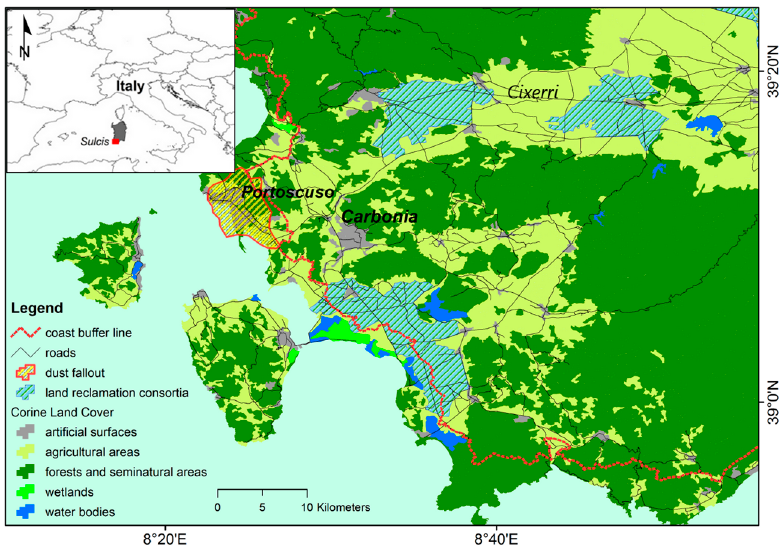
Figure 1. Map of the study area. Representation with Corine Land Cover 2012 at first level of nomenclature (five classes).